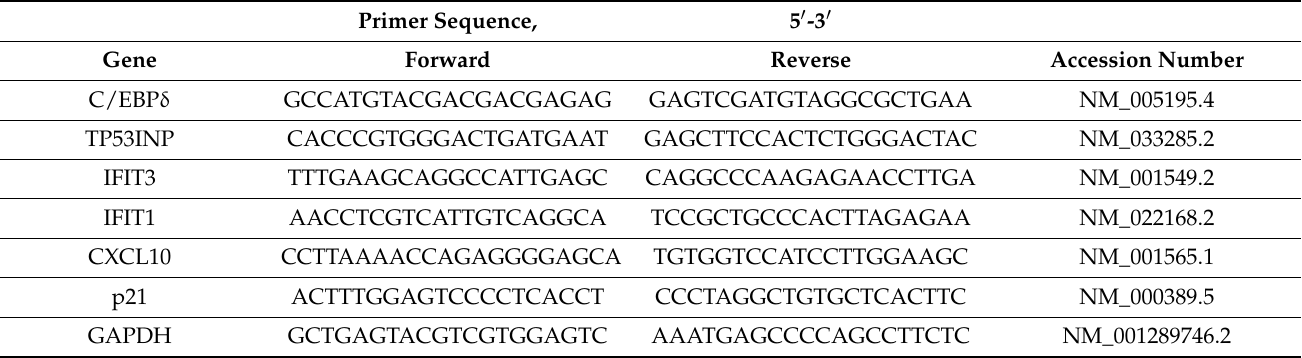
Table 1. Sequences for qRT-PCR